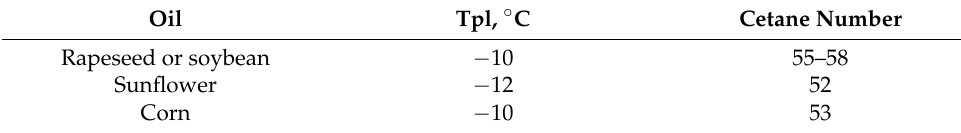
Table 2. Properties of biofuel manufactured from different raw